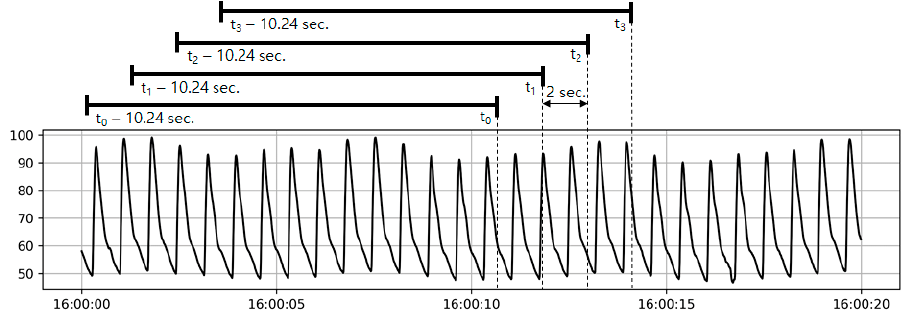
Figure 1. Representative figure describes how an input record is generated. For a time point t 0 , an input vector consists of arterial blood pressure (ABP) waveform between t 0 –10.24 sec, and t 0 . Since the waveform data is collected at a sampling rate of 100 Hz, each input vector has 1024 ABP values. SV PAC measured at t 0 is regarded as a reference and SV EV1000 measured at t 0 is regarded as a competitor. Data records were generated once 2 seconds so neighboring records overlap each other.